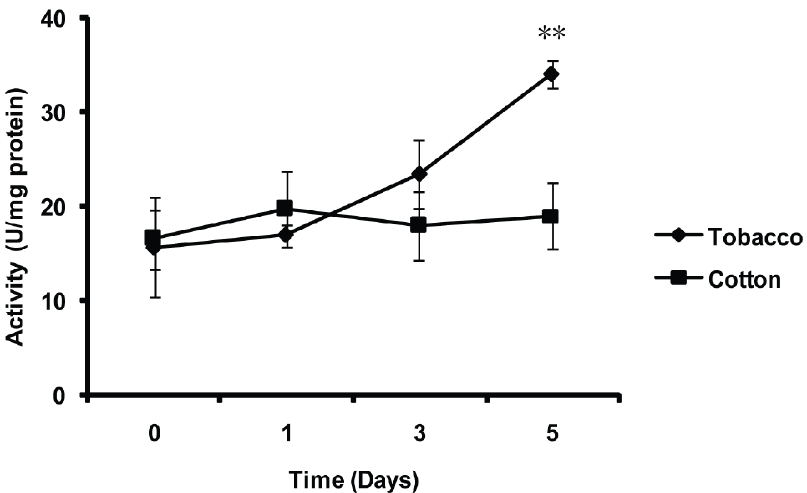
Figure 8. Effect of host shift on MnSOD activity of whitefly in vivo . Each symbol and bar represents the mean ± SD of MnSOD activity ( n = 3). Significant differences between various sampling times of each host plant compared with 0 days are indicated by two asterisks at p < 0.01 (LSD test).